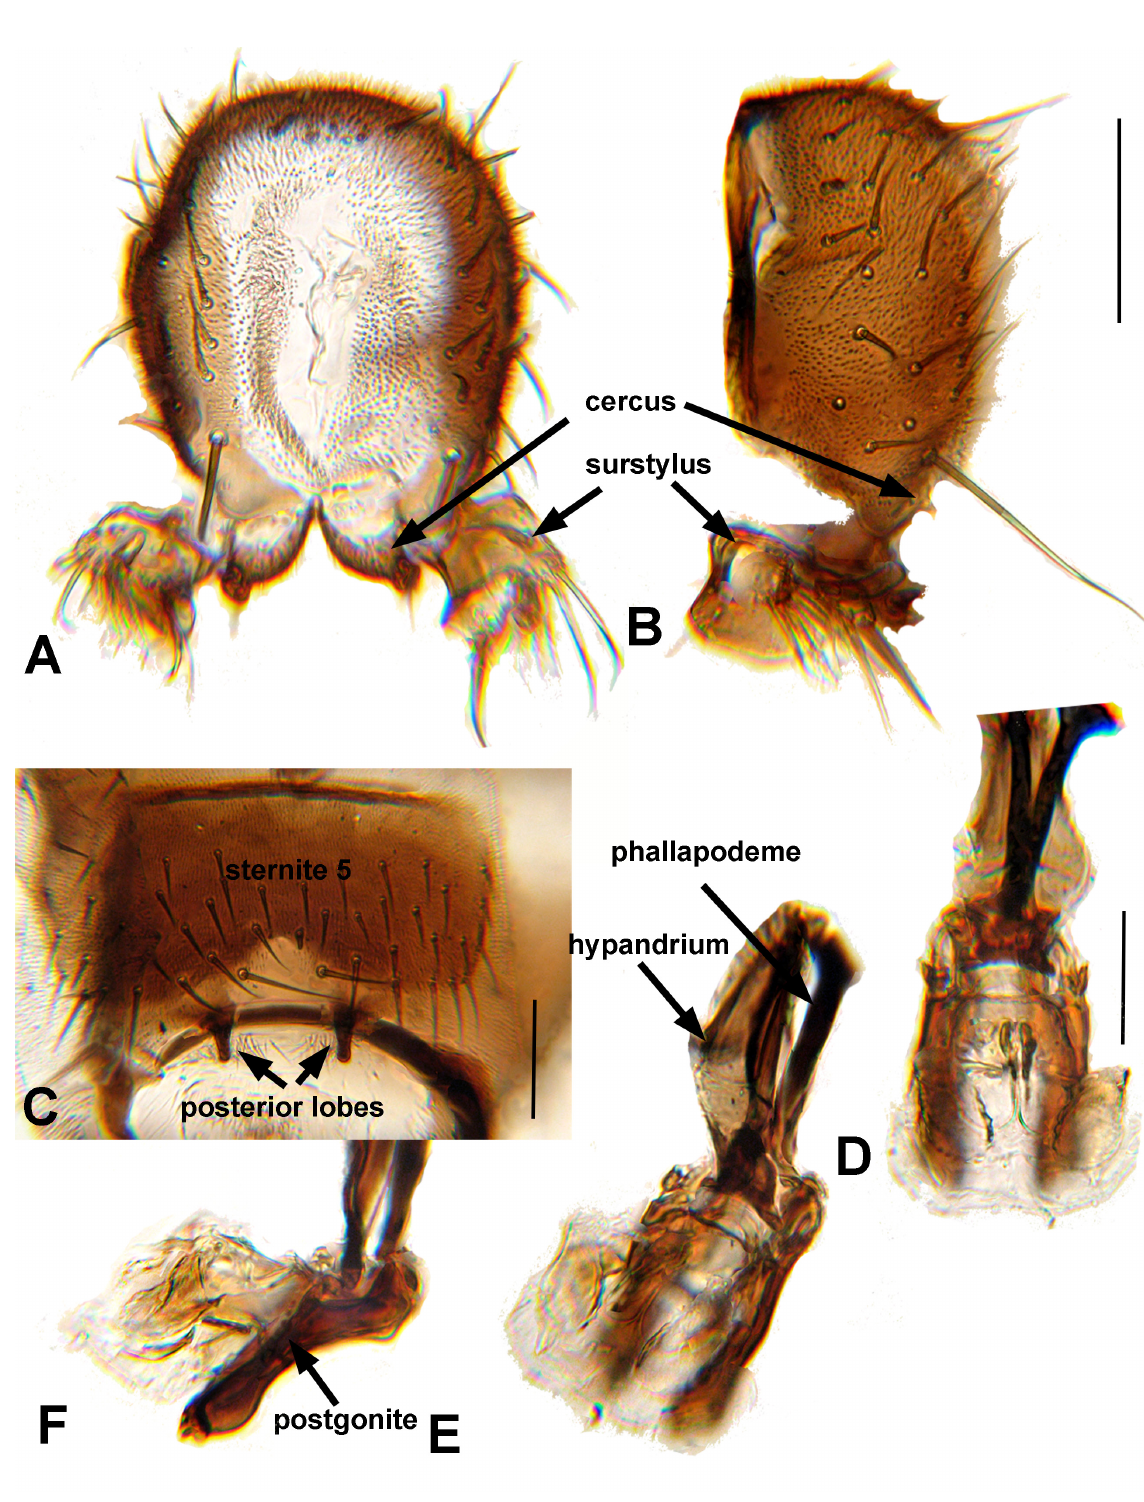
Fig. 16. Rudolfina pauca sp. nov., male terminalia (debu1086247). A . Epandrium, surstylus and cercus, caudal view. B . Same as preceding, lateral view. C . Sternite 5, ventral view. D . Phallus, postgonites and phallapodeme, dorsal view. E . Phallus, postgonites, hypandrium and phallapodeme, dorsolateral view. F . Same as preceding, lateral view. Scale bars: A–B = 0.10 mm; C = 0.10 mm; D–F = 0.05